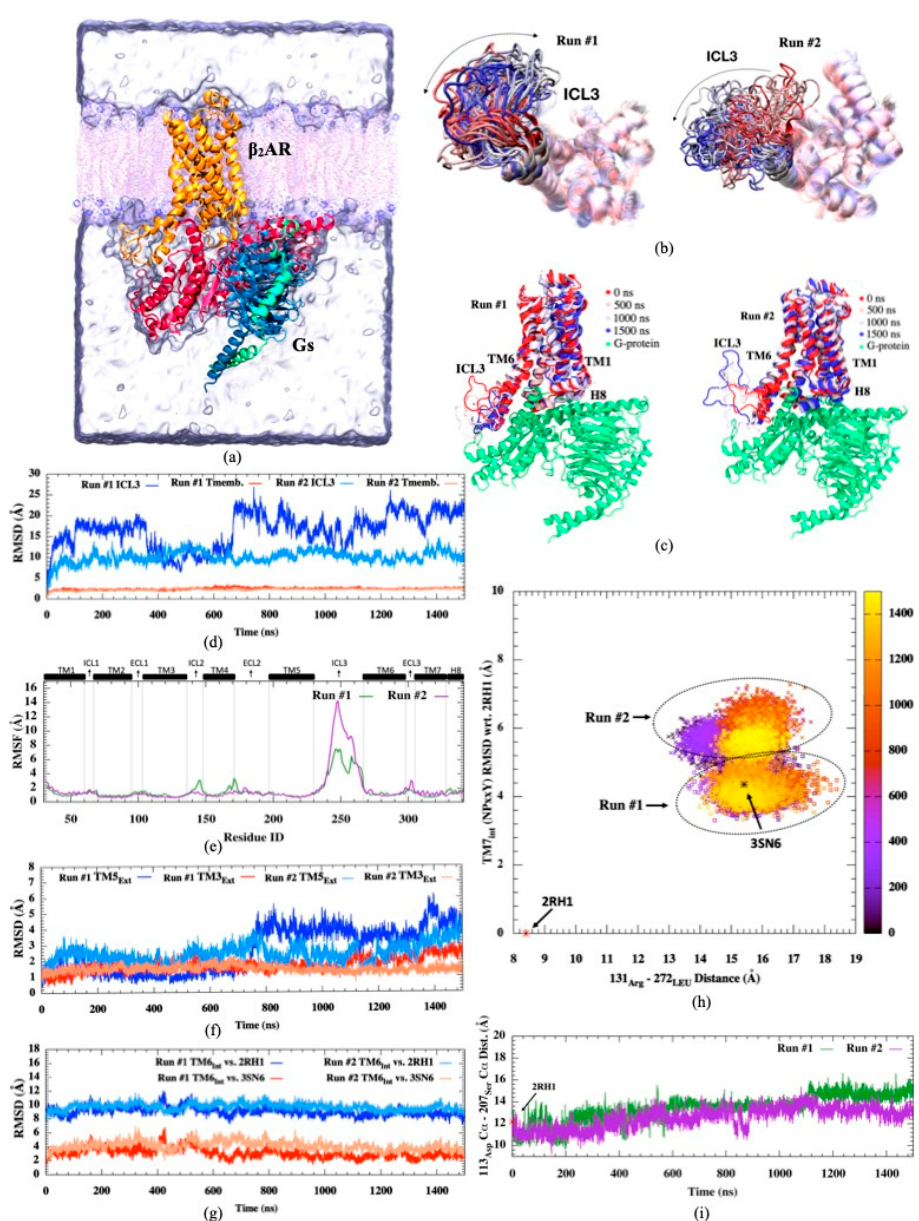
Figure 1. ( a ) Representation of human β 2 AR in a complex with Gs complex in a membrane environ- ment (created via VMD visualization tool [30]), ( b ) Intracellular views of 20 snapshots of ICL3 ( c ) side views of β 2 AR-Gs complex for 4 different snapshots colored from red (initial) to white (inter- mediate), to blue (final) during simulation ( d ) RMSD profiles of ICL3 and transmembrane regions, ( e ) RMSF profiles ( f ) RMSD profile of extracellular parts of TM3 and TM5 helices, ( g ) RMSD profiles of intracellular parts of TM6, ( h ) RMSD of NPxxY motif of TM7 with respect to the inactive state (PDB id:2RH1) versus ionic lock distance ( Arg131C α - Leu272C α ), ( i ) distance profile for Asp113C α - Ser207C α residue